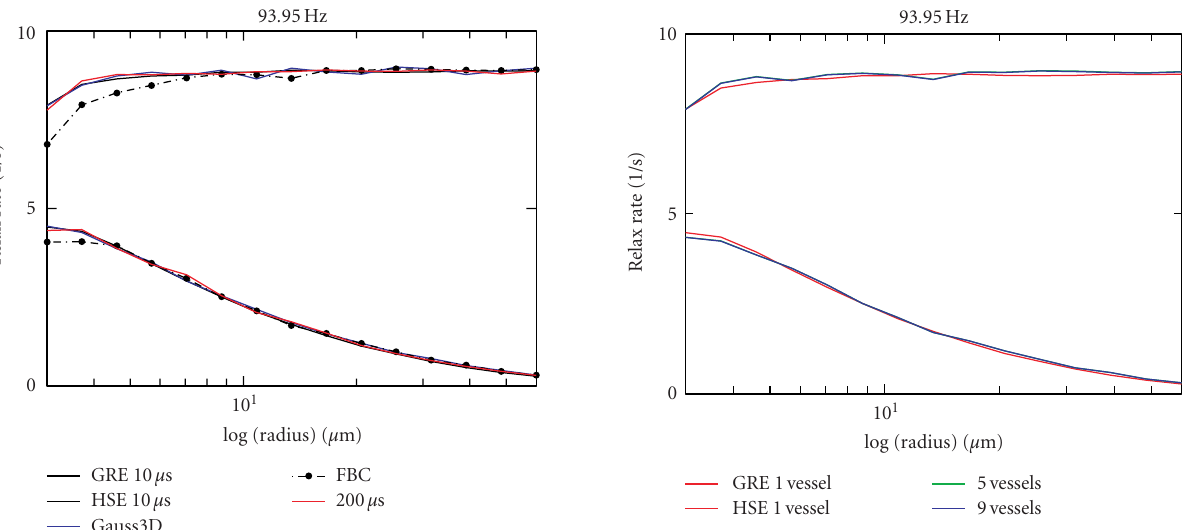
Figure 5: R2/R2 ∗ relaxation rate (in s − 1 ) for time step length of 10 microseconds versus 200 microseconds. Data for the Gauss3D step and for the free boundary conditions are also shown. The free boundary condition data clearly deviate from the other data.